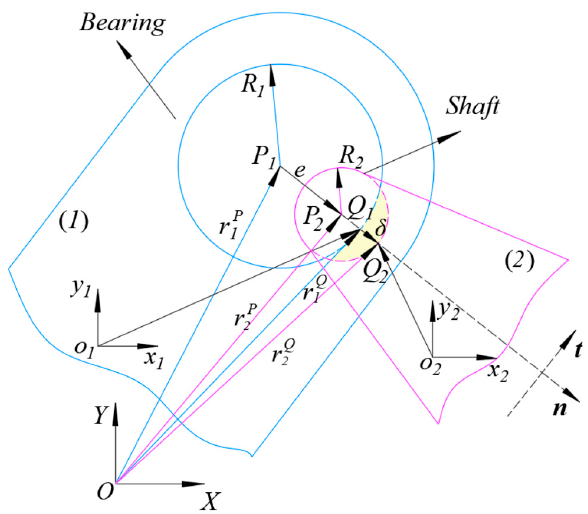
Figure 1. Clearance model of a revolute pair.